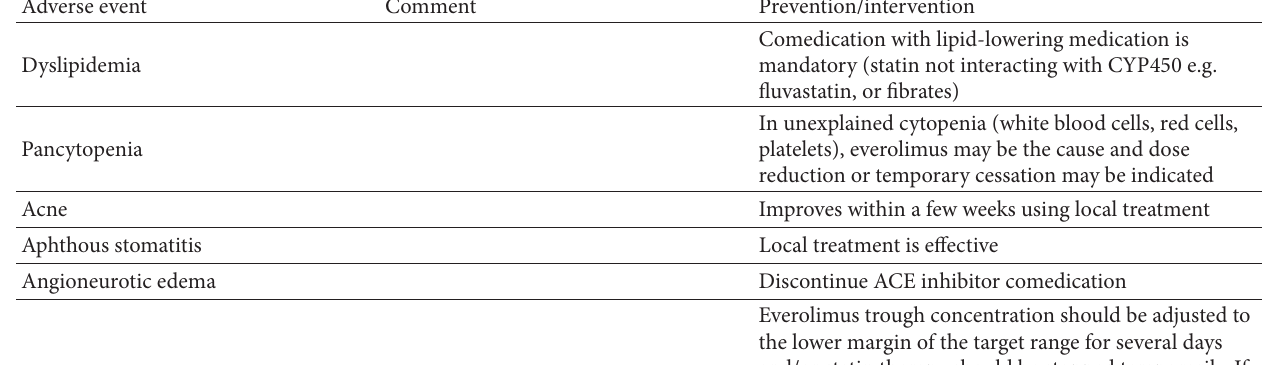
Table 5: Overview of selected everolimus-associated adverse